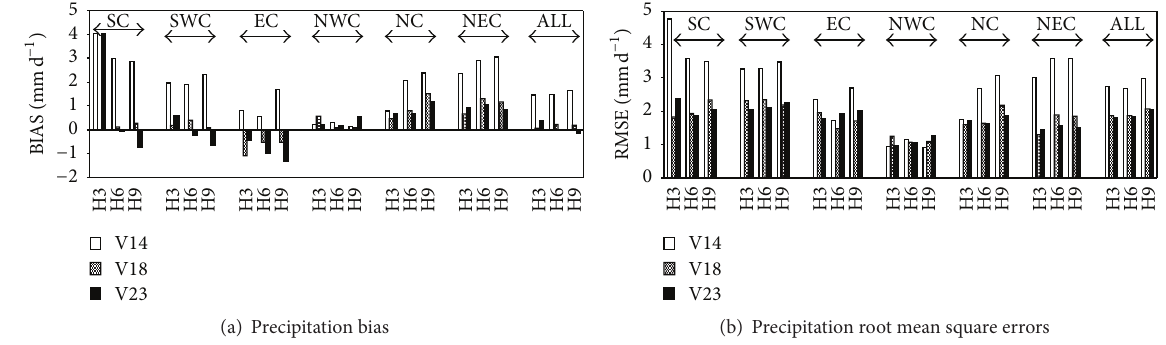
Figure 6: Bias (a) and RMSE (b) of summer-mean precipitation for the studied